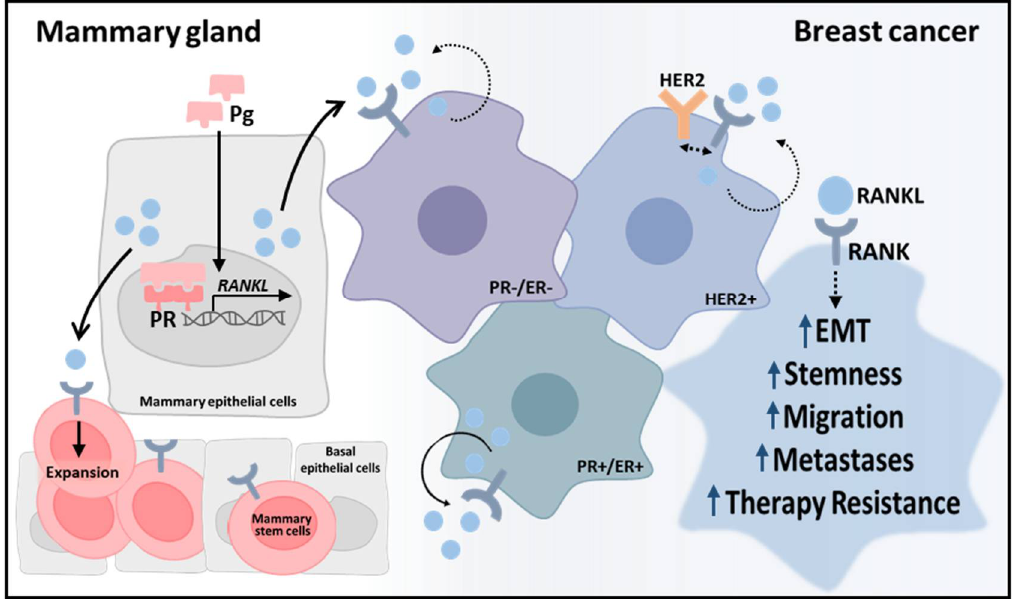
Figure 3. The role of RANKL/RANK signaling in the breast spans from physiologic development to breast cancer (BCa). RANKL expression in mammary epithelial cells is regulated by progesterone (Pg)-activated receptors and activates RANK in RANK-expressing luminal and basal cells, promoting proliferation, differentiation, migration, and survival. Expansion of mammary stem cells is associated with carcinogenesis. In BCa cells, RANKL-RANK signaling pathway is associated with aggressiveness features independently of subtype, including epithelial-to-mesenchymal transition (EMT), stemness, migration, metastases and therapy resistance.